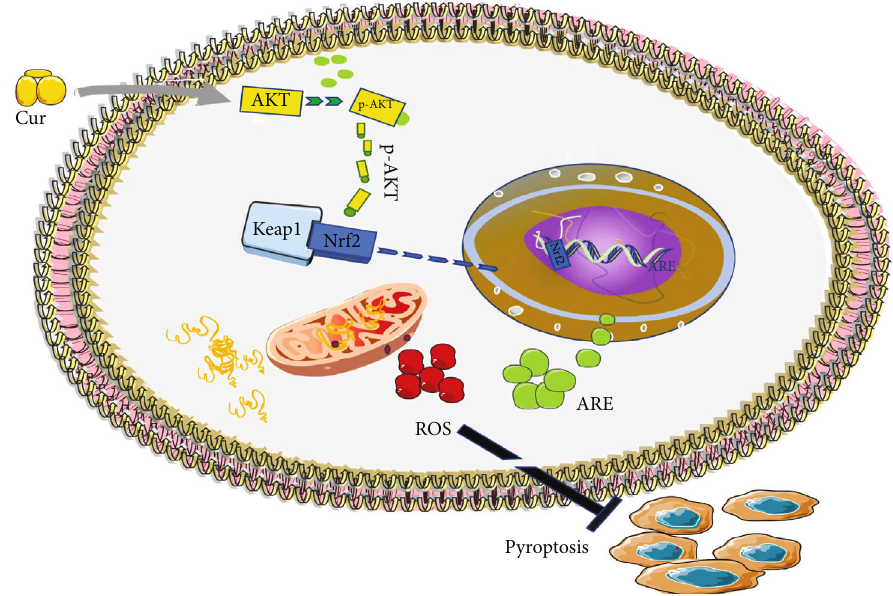
Figure 8: Schematic diagram of curcumin inhibiting pyroptosis through the Nrf2/AKT/ARE